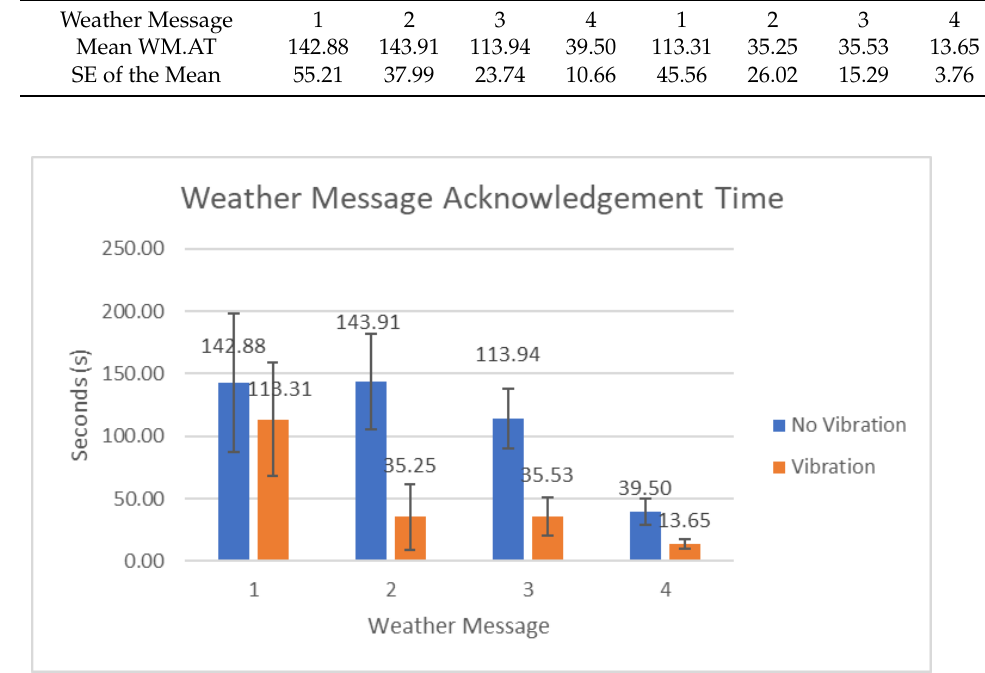
Figure 5. Weather message acknowledgement time (WM.AT) to the four weather messages (WMs) for each participant group, “No Vibration” (NV) and “Vibration” (V). Bars provide mean values with error bars representing standard error of the mean.